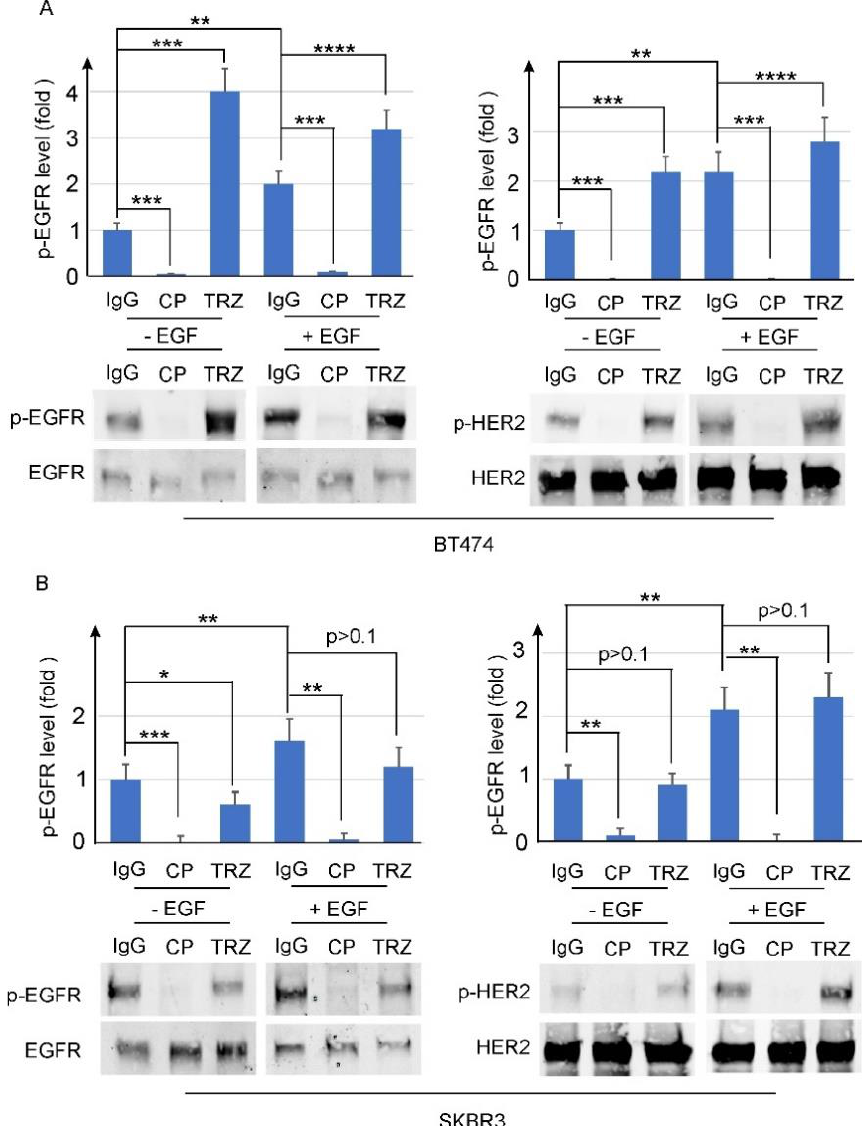
Figure 4. The effects of trastuzumab on the phosphorylation of HER receptors in BT474 ( A ) and SKBR3 ( B ) cells. The cells treated with trastuzumab at concentration of 10 µg/mL in the presence and absence of EGF at 50 ng/mL concentration. The phosphorylation of HER receptors was revealed by immunoblotting. Cells treated with normal human IgG were used as negative control and cells treated with CP – 714724 (CP) at 1 µM concentration were used as positive control. Each value is the average of at least three experiments and the error bar is standard error. *: p < 0.05, **: p < 0.01, ***: p < 0.001, ****: p < 0.0001.